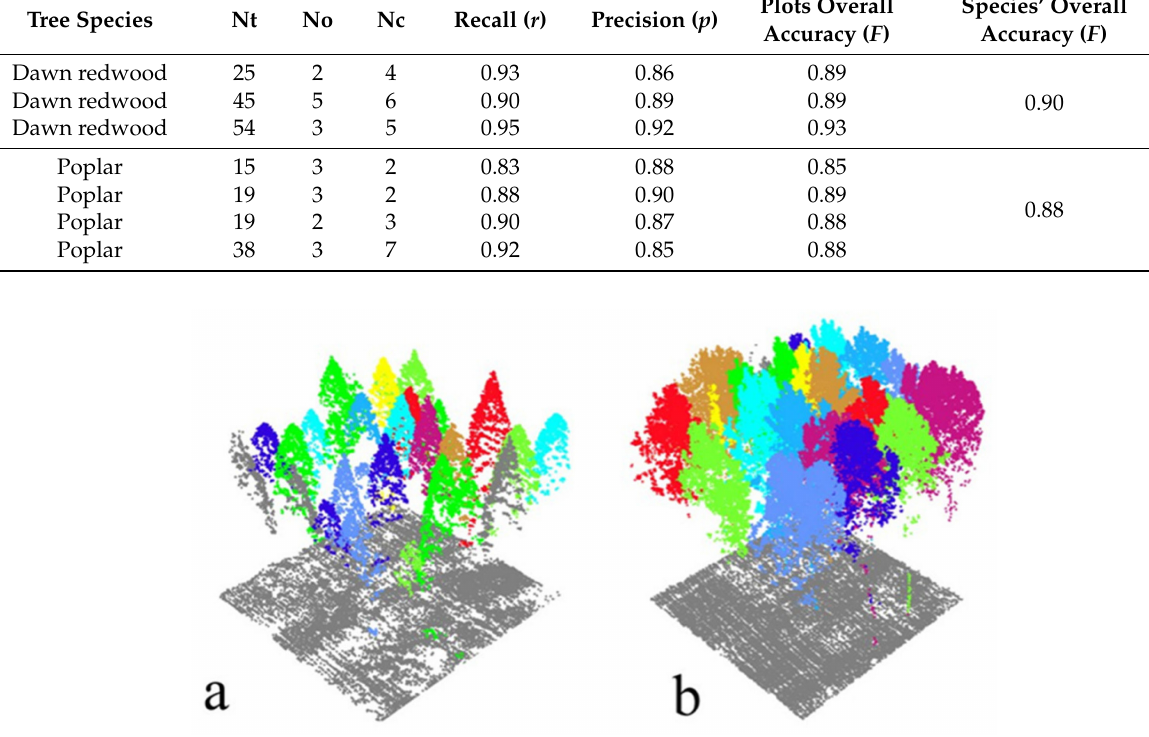
Figure 2. Single-tree segmentation results with the ULS data; point clouds of the same color show the same tree. ( a ) The segmentation results of a dawn redwood plot; ( b ) the segmentation results of a poplar